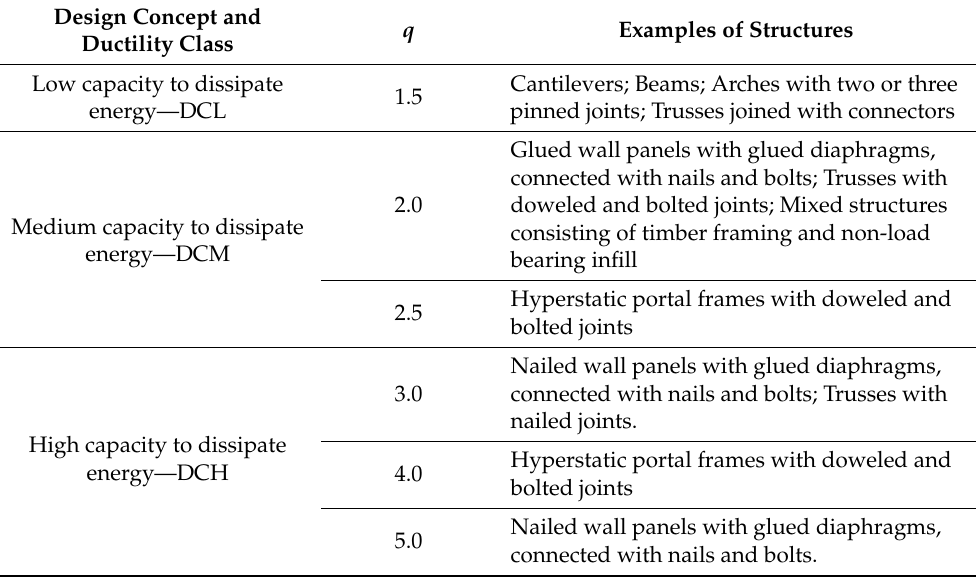
Table 2. Ductility classes for structure proposed in Eurocode 8 (Adapted from Ref. [3]).